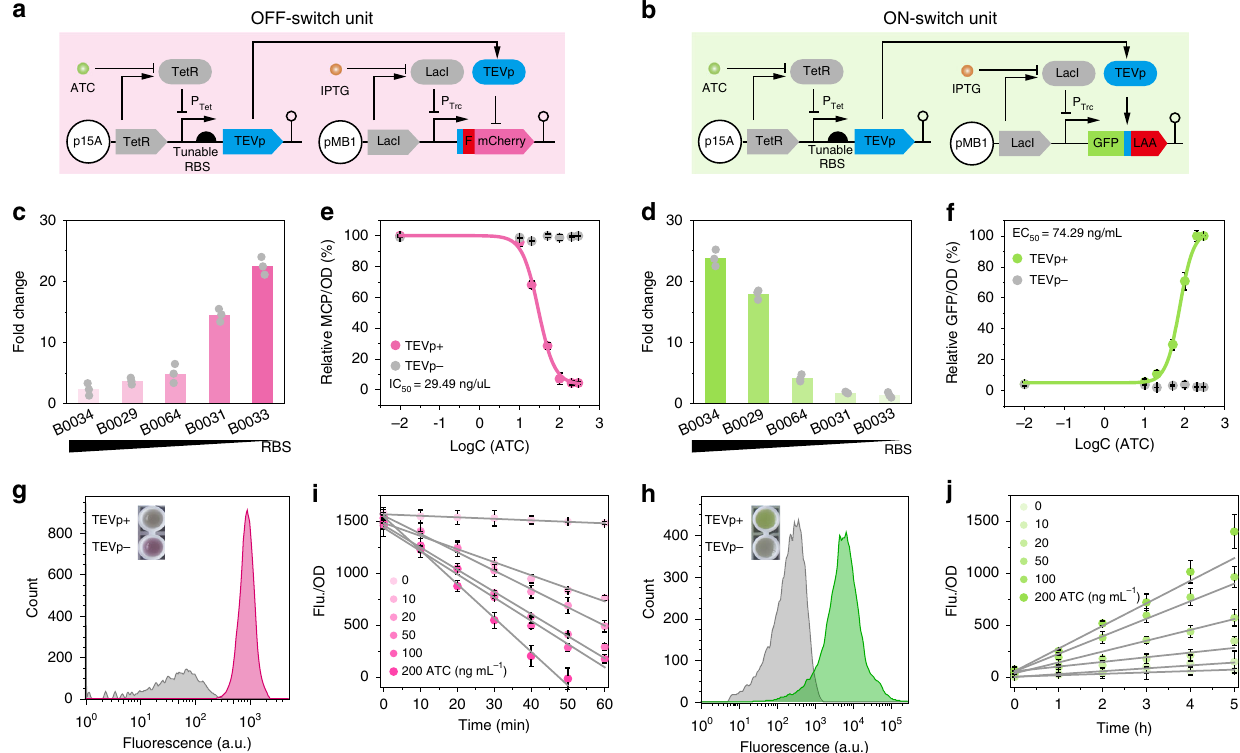
Fig. 1 Basic protein regulatory unit design and characterization. a , b Design of the OFF-switch ( a ) and ON-switch ( b ) regulatory unit. c , d The dynamic range of reporter protein abundance by varying TEVp expression with ribosome binding site (RBS) variants in OFF-switch unit ( c ) and ON-switch unit ( d ). e Dose – response curve of OFF-switch unit (with B0033 RBS controlled TEVp) by varying inducer anhydrotetracycline (ATC) concentration. Nonlinear DoseResp model was utilized to fi t the data shown by the magenta lines. IC 50 , half maximal inhibitory concentration. f Dose – response curve of ON-switch unit (with B0034 RBS controlled TEVp). Nonlinear DoseResp model was utilized to fi t the data shown by the green lines. EC 50 , effective inducer concentration. g Flow cytometry diagrams of the control and the diagrams of the OFF-switch unit are represented by red tone traces and gray tone traces, respectively. h Flow cytometry diagrams of the control and the diagrams of the ON-switch unit are represented by gray tone traces and green tone traces, respectively. i The kinetic of OFF-switch unit (with B0033 RBS controlled TEVp) by varying ATC concentration in Luria-Bertani (LB) medium. j The kinetic of ON-switch unit (with B0034 RBS controlled TEVp) by varying ATC concentration in LB medium. TEVp + /TEVp − represents samples with ( + ) or without ( − ) ATC. Values are shown as mean ± SD from three biological replicates. Source data of Fig. 1c – f, 1i, and 1j are provided in Source Data fi